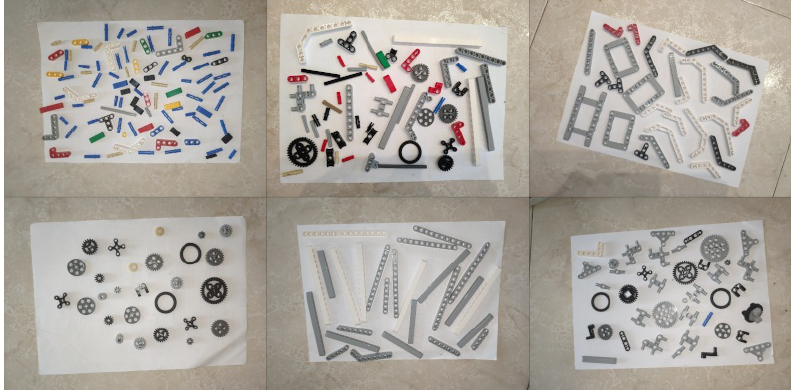
Figure 4. Real dataset with real-world images taken perpendicularly, with controlled light and fixed white background.